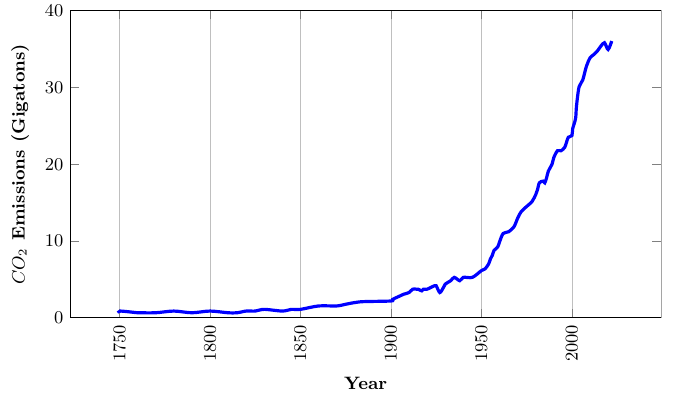
Figure 1. Annual CO 2 emissions from all industrial activities (Adapted from IEA Global Energy Review [11]).